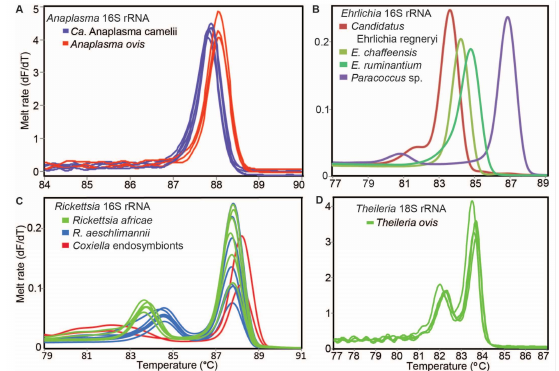
Figure 4. Representative melt rate profiles of tick-borne pathogens in tick samples collected from camels and sheep in northern Kenya. PCR-amplicon melt rates are represented as change in fluores- cence with increasing temperature (dF/dT) of ( A ) Anaplasma 16S rRNA, ( B ) Ehrlichia 16S rRNA, ( C ) Rickettsia 16S rRNA and ( D ) Theileria 18S rRNA gene amplicons.